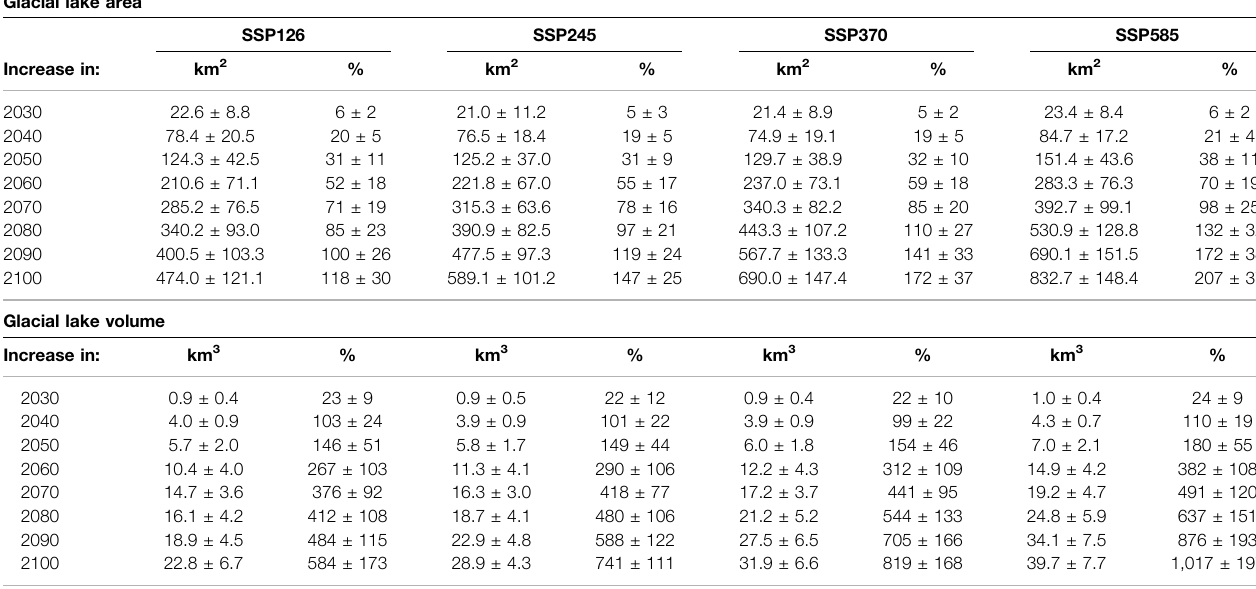
Frontiers in Earth Science |